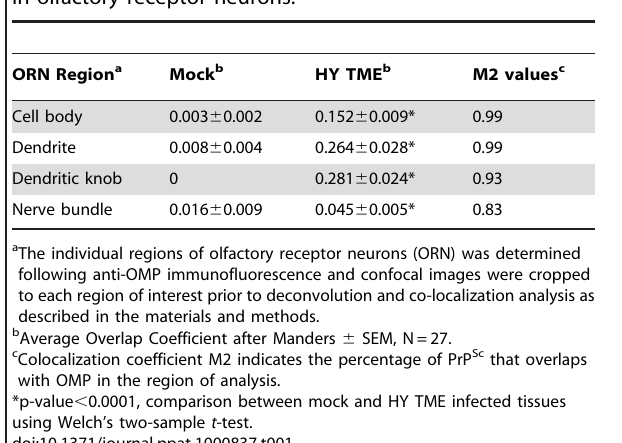
Table 1. Colocalization of PrP Sc and olfactory marker protein in olfactory receptor